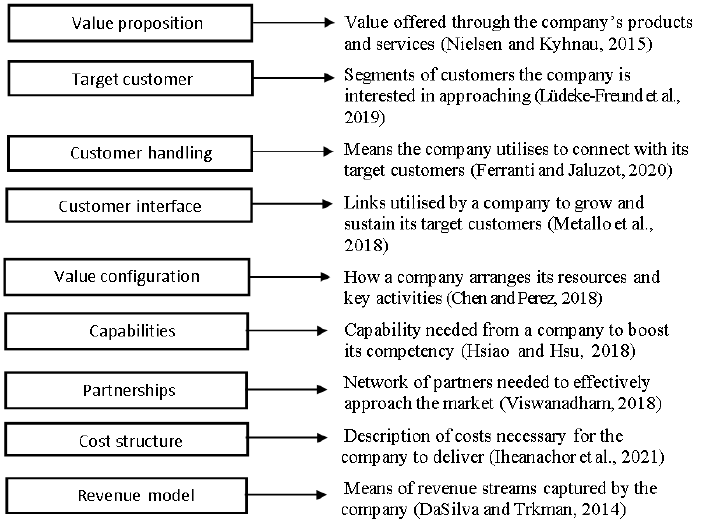
Figure 1. Nine business model elements—modified from Osterwalder [38]. Note (s): Nielsen 2015